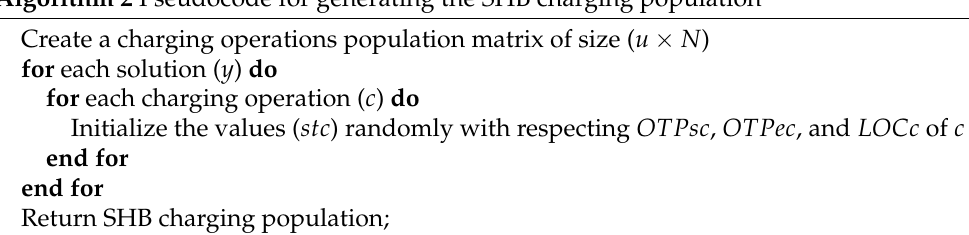
Algorithm 2 Pseudocode for generating the SHB charging